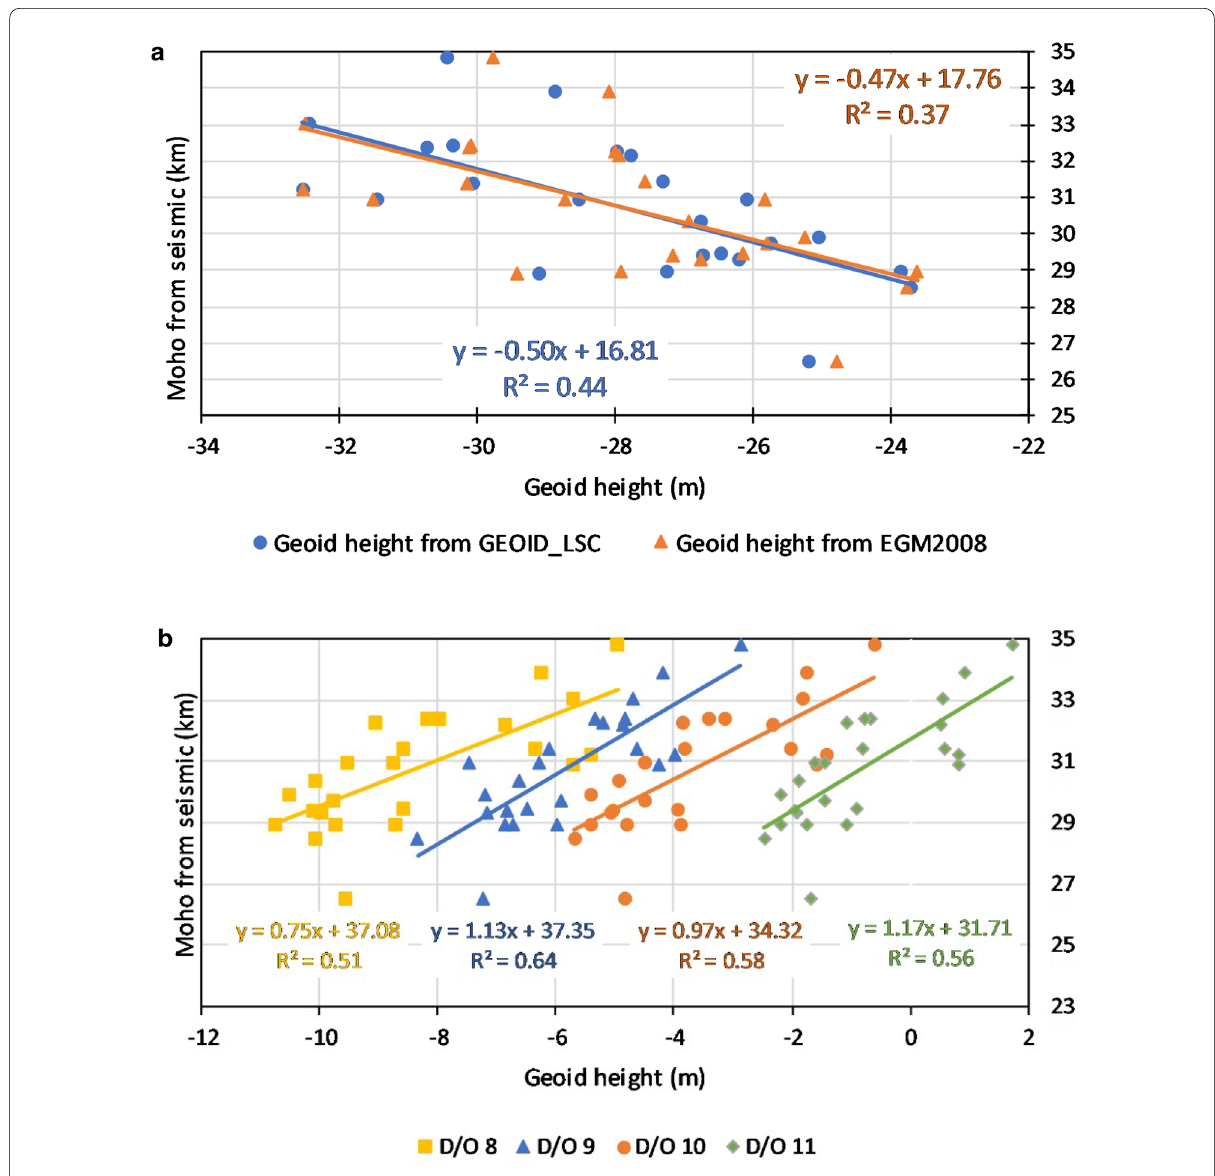
Fig. 3 Relation between Moho depths beneath seismic stations and corresponding geoid undulation retrieved from a GEOID_LSC_C and EGM2008 and b GEOID_LSC_C after removing low